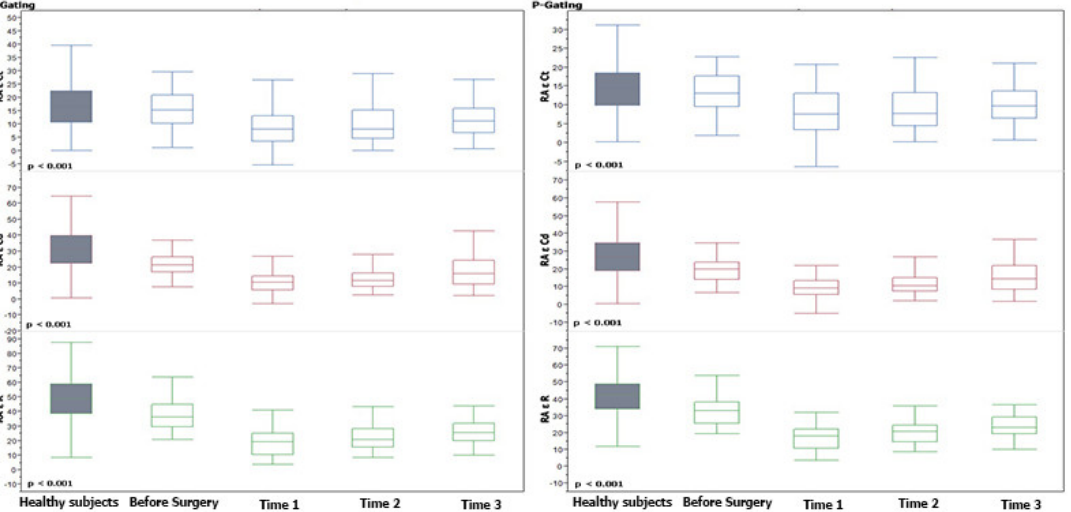
Figure 4. Right Atrial Strain trends at different pre-/post-operative times and in comparison to the control group. Median and interquartile range of ε values over time are shown. p values in the patient group were determined relative to strain from Time 1 to Time 3. Horizontal line = median; Box = interquartile range.